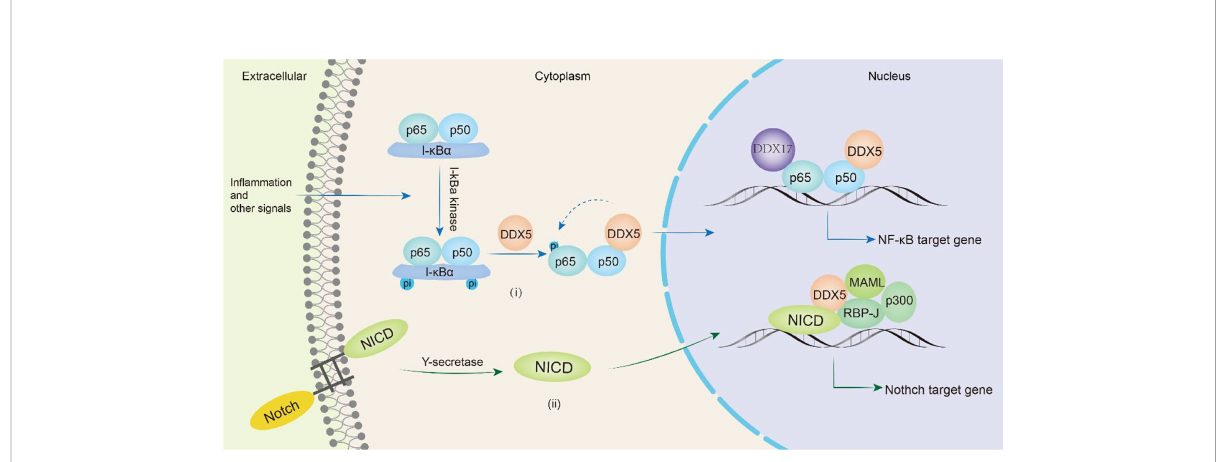
FIGURE 5 DDX5/DDX17 are involved in tumor progression through NF- k B and Notch signaling pathways. In the NF- k B signaling pathway(i), DDX5 promotes the release of the inhibitory subunit I k B a , induces nuclear translocation of the p50 subunit, and in directly phosphorylates the p65 subunit, thereby promoting the transcription of NF- k B target genes. DDX17 is involved in alternative splicing of p65 subunit target genes such as CD44. In the Notch signaling pathway(ii), DDX5 binds MAML1 and is recruited to the Notch We would like to delete the entire glossary section. Please see below. transcription complex to promote the transcription of target